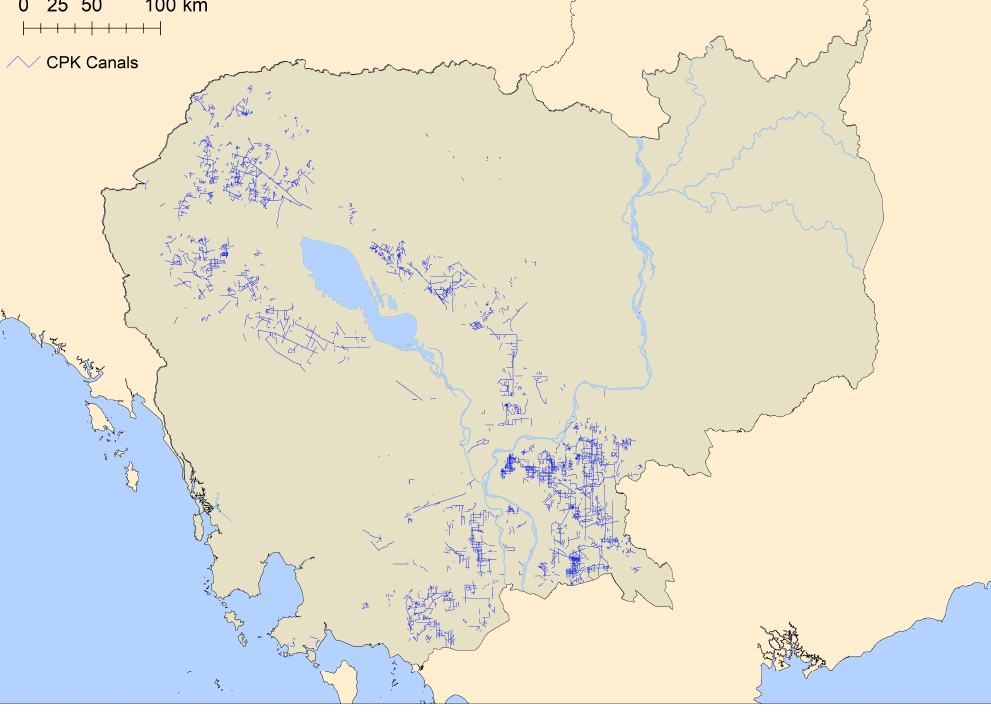
Figure 5. Results of canal mapping from 1979 imagery.